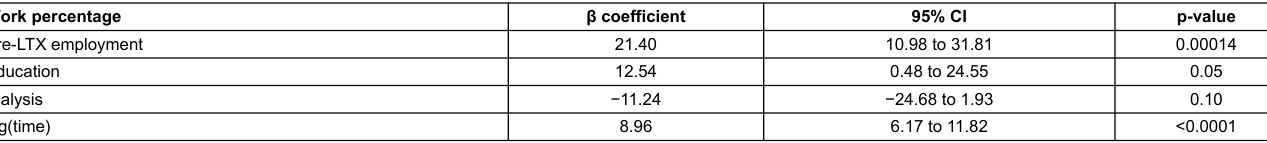
Table 4: Mixed linear regression model for work percentage post lung